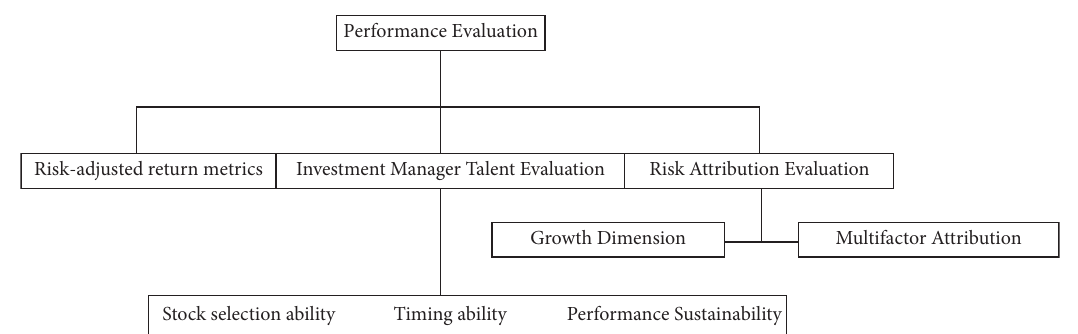
Figure 1: Current performance evaluation